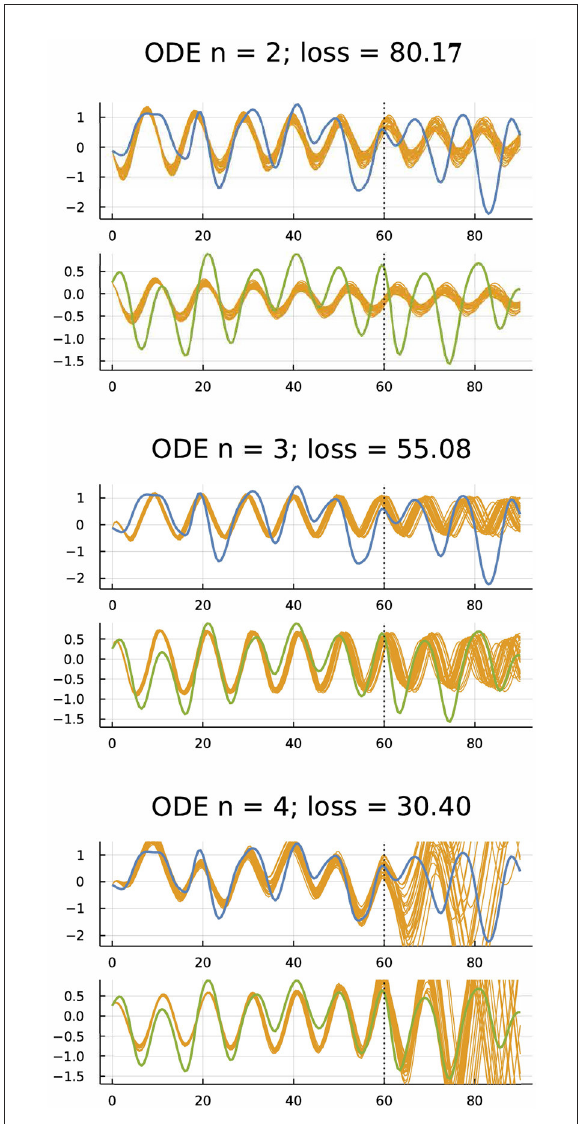
FIGURE2 Dynamics of hare (blue) and lynx (green) populations (Odum and Barrett, 1971; Bonnaffé et al., 2021) and fitted models (gold) (Frank, 2022b). The ordinary differential equation (ODE) models were fit to the first 61 yearly observations. The gold curves past year 60 show predictions for subsequent dynamics. For n = 2, the model had one variable for hare and one for lynx. For n = 3,4, the model had one or two extra variables to account for possible unobserved factors, providing more parameters to fit the data. Smaller loss means a better fit to the first 60 years. The model fitting was done by an approximate Bayesian method based on the gradient of the loss calculated by automatic differentiation (Li et al., 2015). For each model, gold trajectories arise from 30 randomly chosen parameter combinations of the Bayesian posterior distribution. From Figure 4 of Frank (2022b), which provides methods, a broader analysis of these data, and other fitting approaches such as neural ODEs that use artificial neural networks to fit differential equations to target